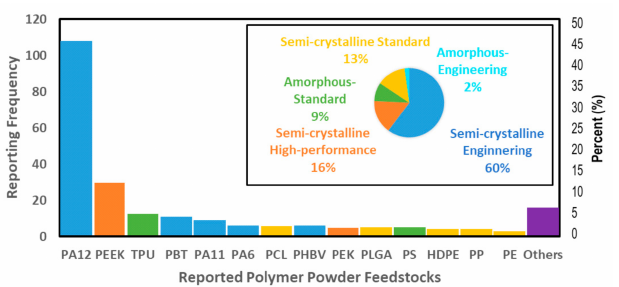
Figure 4. Reported polymer powder feedstocks processed by L-PBF. Others consist of POM, PU, DF, PA12-PEG blend, PA12-PVA blend, PEKK, PMMA, cellulose acetate, and starch-cellulose studied three times or less in the publications [11–111]. The inset shows the share of parent class